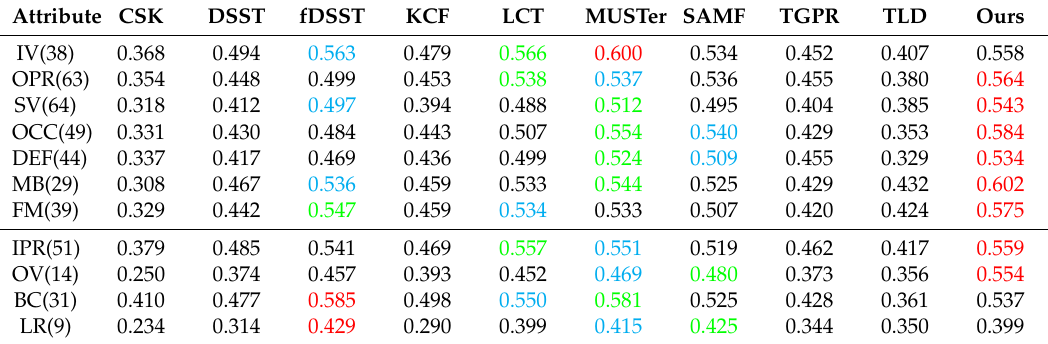
Table 3. Attribute-based analysis of OTB-2015 (success rate based on AUC score). The first, second and third highest results are colored red, green and blue, respectively.